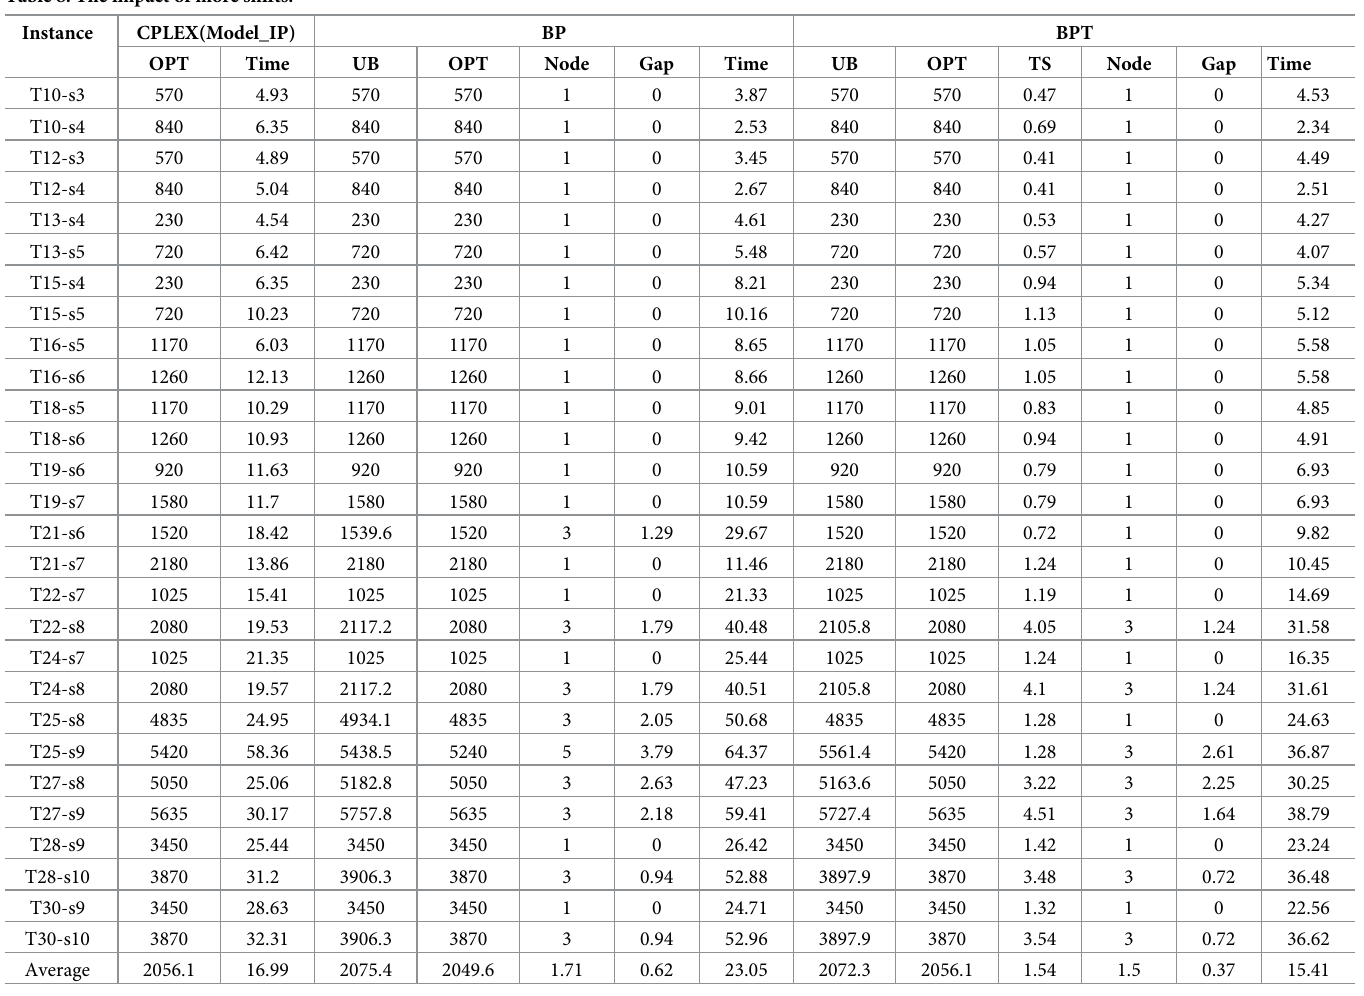
Table 8. The impact of more shifts.